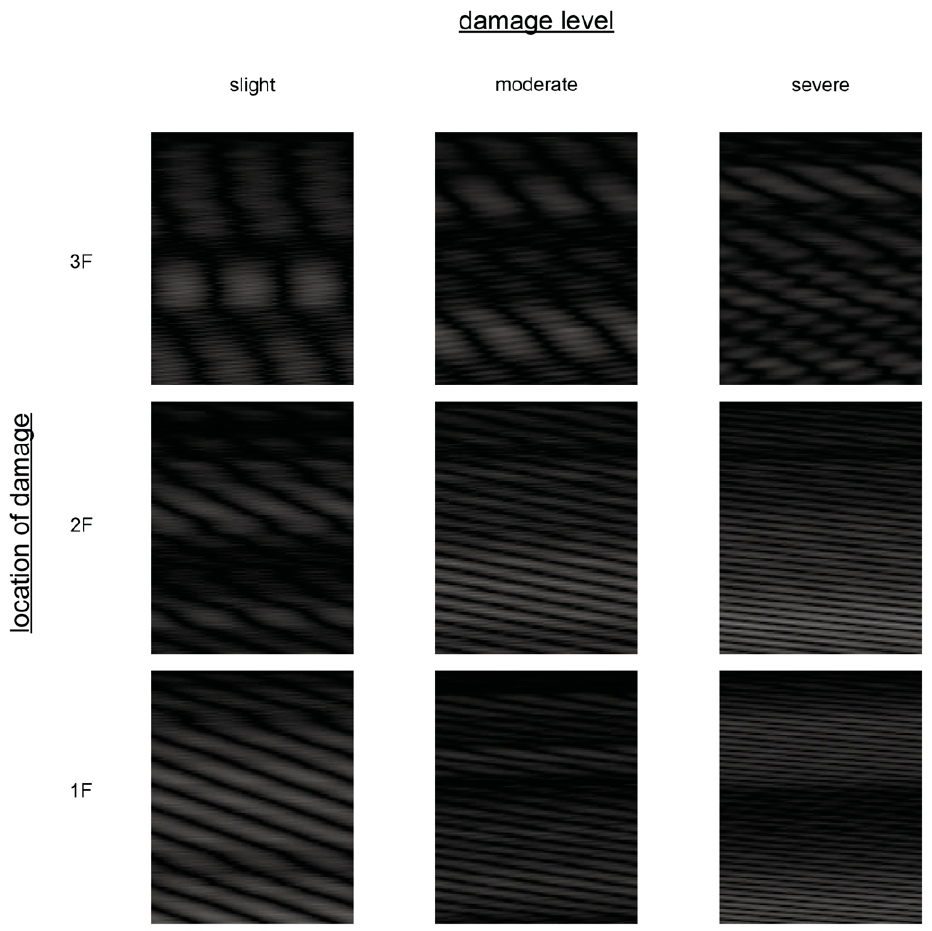
Figure 6. Examples of the reconstruction in the image space. These correspond to the reconstruc- tions shown in Figure